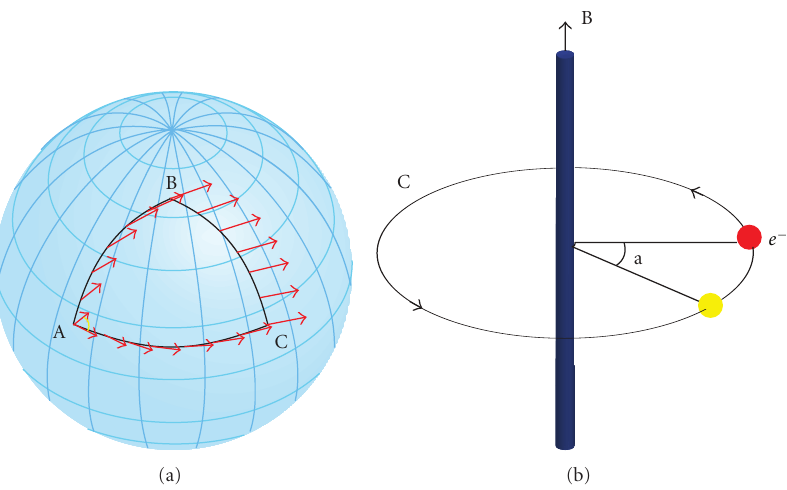
Figure 1: (a) A diagram illustrating parallel transport of a vector constrained to stay tangential to the surface of a sphere: if the red arrow is transported around a closed loop from A → B → C, this constraint causes it to undergo a rotation. The angle of rotation arises from the geometry of the vectors path and is an example of a Berry phase. (b) A schematic of the Aharonov-Bohm e ff ect: an electron processing around an enclosed magnetic field via a loop, C, acquires a Berry phase, a ( = γ n ), due to coupling of its wavefunction to the magnetic vector potential, despite there being a negligible magnetic field along the path of the electron. The e ff ect is a consequence of the requirement that the electromagnetic potential be invariant with respect to a fixed